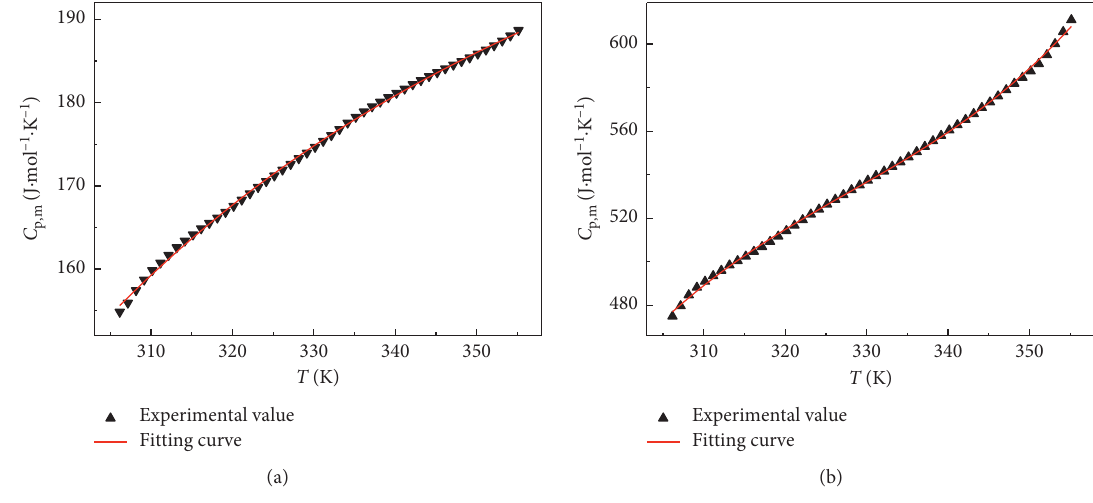
Figure 3: Molar heat capacities versus temperature in the range of 306.15K to 355.15K for pinnoite (a) and inderite (b). Table 3: Polynomial coefficients of equation (1) for minerals of pinnoite and inderite at 306.15 ∼ 355.15K.